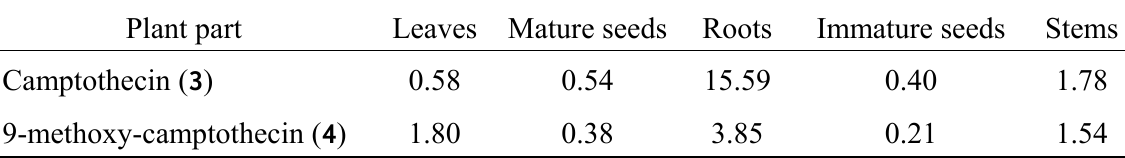
Table 3 . The contents of compounds 3 , 4 from different parts of N. foetida (g/Kg).